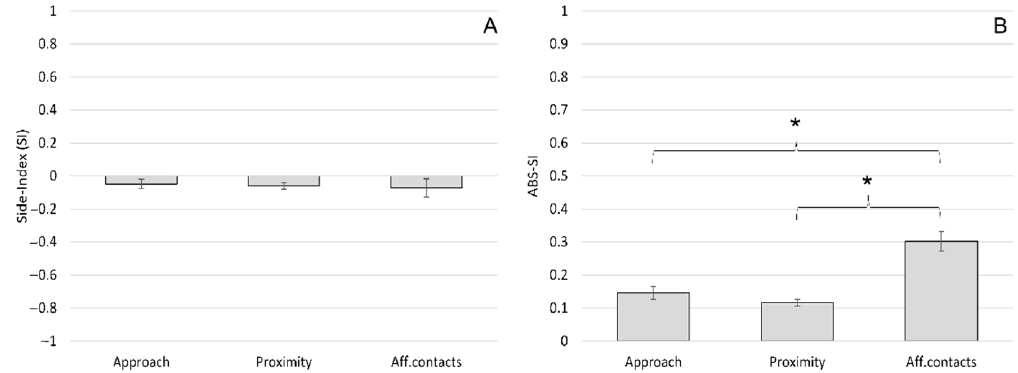
Figure 2. Side preference during social interactions in Barbary macaques . Mean Side Index (SI) ( A ) and mean ABS-SI ( B ) of different social interactions (approach, proximity and affiliative contact). Bars indicate standard error. Asterisks (*) indicate significant differences between social interactions (Tukey post hoc test: p <